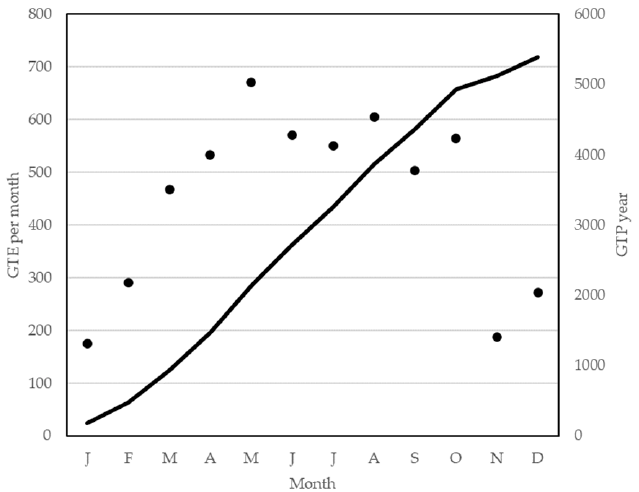
Figure 5. Greenhouse Thermal Effectiveness (GTE) and Greenhouse Thermal Potential (GTP) esti- Figure 5. GTE estimated in the region of Chalco and potential using average temperature (°C) as a mated in the region of Chalco by using average temperature ( ◦ C) as a boundary condition to simulate boundary condition to simulate inside-the-greenhouse temperature with CFD. inside-the-greenhouse temperature with CFD.